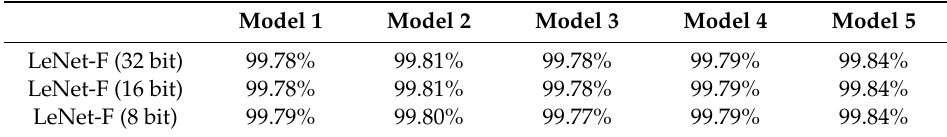
Table 5. Test accuracy of quantized LeNet-F models.